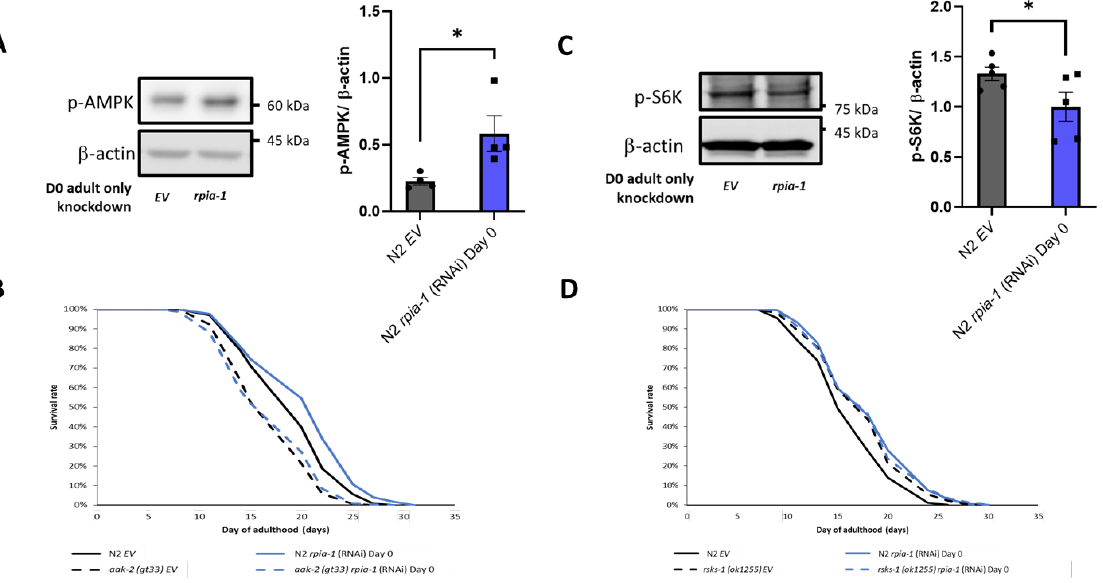
Figure 6. Knockdown of rpia-1 prolongs lifespan through inducing AMPK pathway and reducing TOR pathway. ( A ) Western blotting results showed that ubiquitous knockdown of rpia-1 starting at post-developmental stage elevated p-AMPK levels, indicating increased AMPK pathway activity (3-fold increase; *, p < 0.05, by t -test). ( B ) Ubiquitous knockdown of rpia-1 from day 0 of adulthood in wild type N2 strain prolonged the mean lifespan by 6.7% (blue solid line); in contrast, ubiquitous knockdown of rpia-1 in short-lived aak-2 (gt33) strain (black dashed line, − 10.7%) failed to induce lifespan extension (blue dashed line). ( C ) Western blotting results showed that ubiquitous knockdown of rpia-1 starting at post-developmental stage reduced levels of p-S6K, a marker of TOR pathway activity (0.8-fold; *, p < 0.05, by t -test). ( D ) Ubiquitous knockdown of rpia-1 in wild type N2 strain prolonged the mean lifespan by 11.4% (blue solid line); in contrast, ubiquitous knockdown of rpia-1 in long-lived rsks-1 (ok1255) strain (black dashed line, 7.8%) did not further extend the long-lived lifespan in rsks-1 (ok1255) strain (blue dashed line).